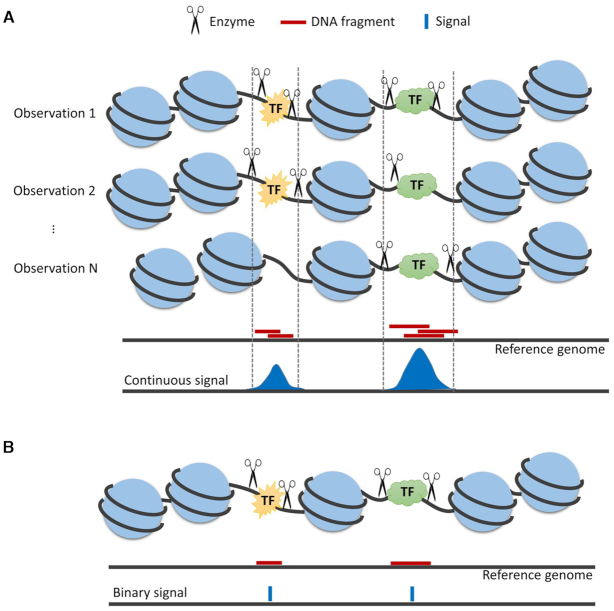
Limitations of existing single-cell regulome mapping technologies. (A) Molecular events such as TF-DNA binding and dissociation are stochastic. For instance, a TF may bind to DNA at one time point and then dissociate from DNA at the next time point. If one observes a cell at a random time point, there is certain probability to observe TF binding, and there is also certain probability to observe no binding. Similarly, if hypothetically one could apply Tn5 treatment in ATAC-seq to the same cell at multiple random time points, Tn5 insertion may occur at some time points but not others. Chromatin accessibility reflects the probability that such molecular events occur at a genomic locus. Regions with higher accessibility tend to have higher probabilities to host such molecular events. Since probability is a continuous measure, chromatin accessibility is arguably a continuous signal. (B) Current single-cell regulome mapping technologies cannot repeatedly measure the same cell multiple times. Instead, they can only measure a cell once since the cell is destroyed during the experiment. Moreover, each genomic locus only has two alleles that can be assayed. As a result, the measurements (i.e. event counts) are highly discrete. Such discrete signals obtained at a single time point are not adequate for describing the continuum of chromatin accessibility (i.e. the probability that molecular events occur at each locus). For instance, observing TF binding at a particular time point is not sufficient for describing the average steady-state TF binding behavior of a cell over time since TF binding may not occur at other time points.